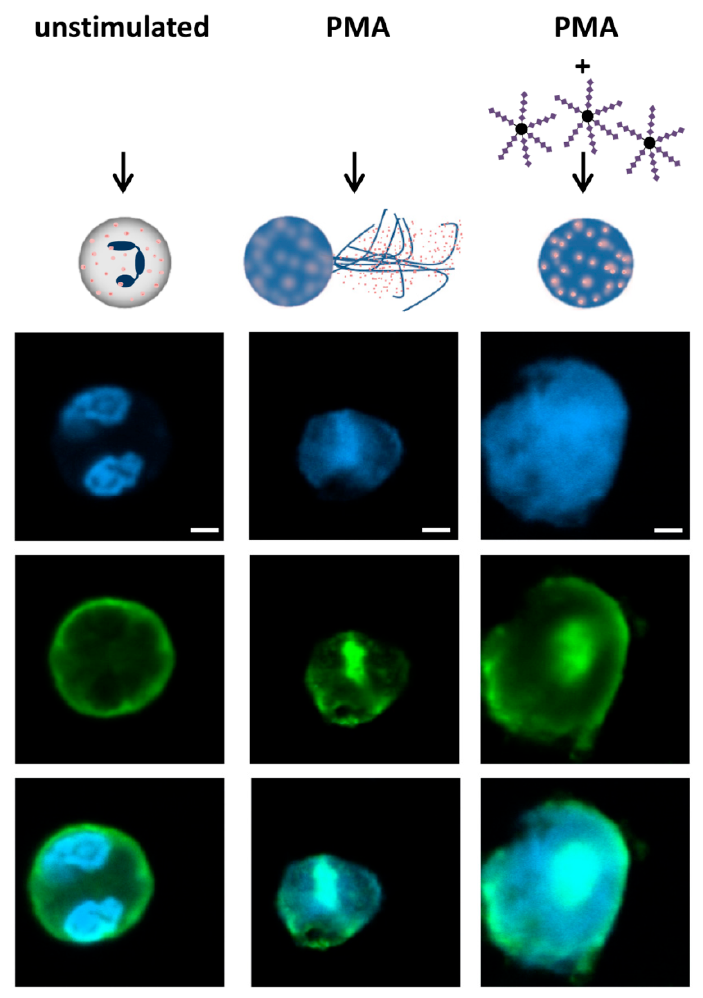
Figure 3. Neutrophil elastase also enters the nucleus during the application of α 2,8-sialylated nanoparticles. Cells were incubated with 20 nM PMA for 2 h and were stained with a polyclonal antibody against neutrophil elastase (FITC; green). DNA was visualized using DAPI (blue). Scale bar: 2 µm.